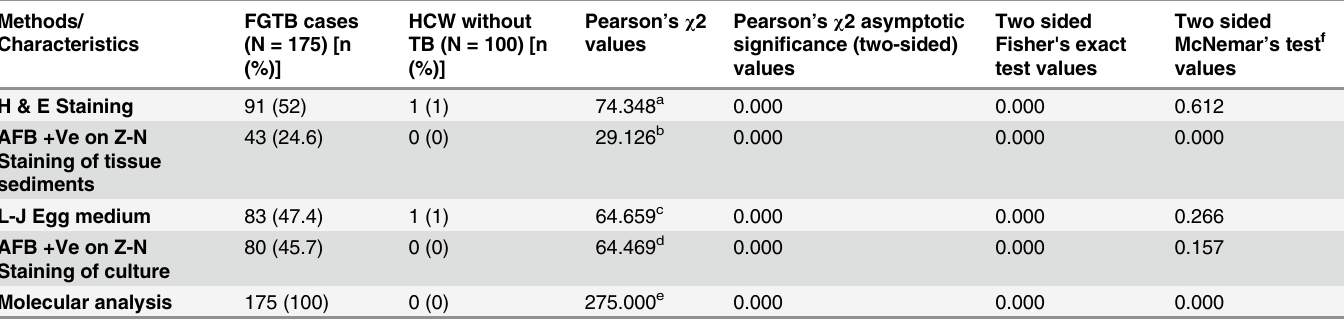
Table 6. Diagnosis and statistical significance of FGTB infection among infertile women and HCW without TB. Methods/